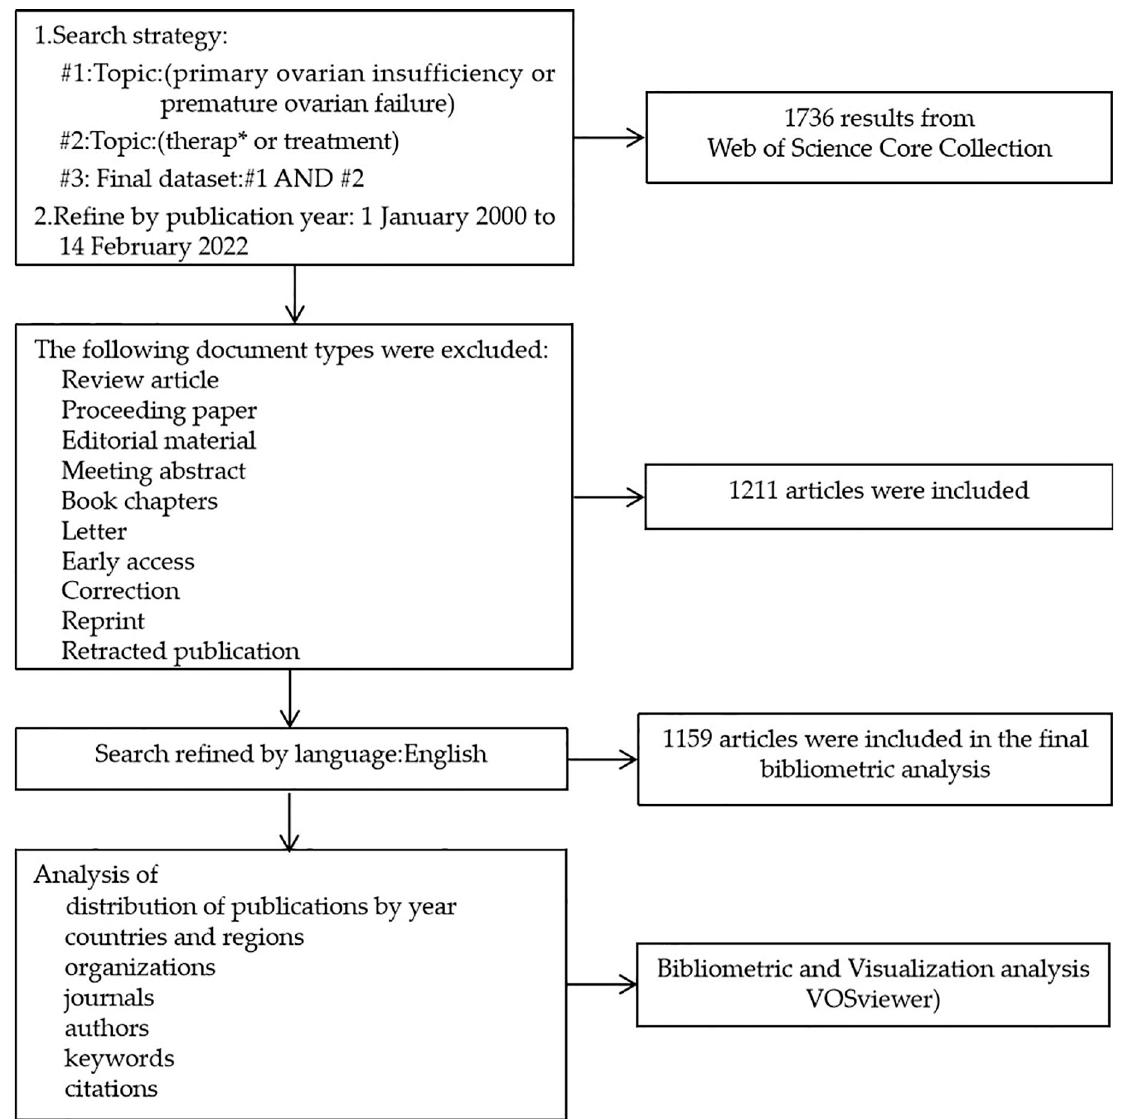
Figure 1. A frame flow diagram of the document search and selection process. The diagram shows detailed selection criteria for POI therapy publications from the Web of Science Core Collection database and the steps of the bibliometric analysis.